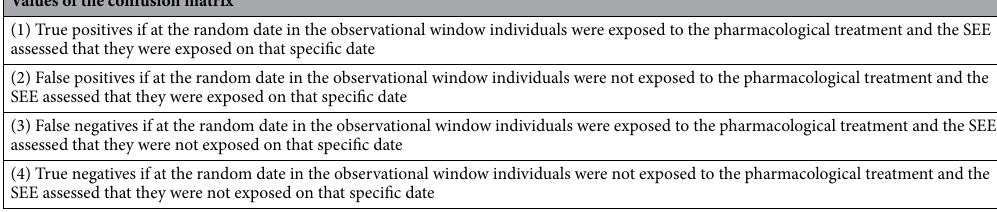
Table 1. Classification of individuals in the confusion